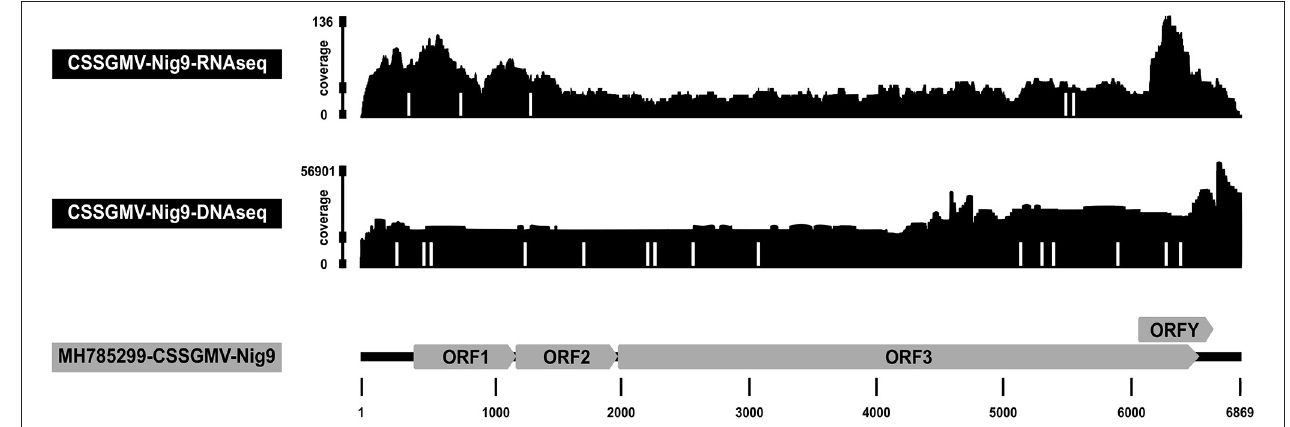
FIGURE 3 | Coverage depth of Illumina reads mapped to the full-length genome of cacao swollen shoot Ghana M virus (CSSGMV)-Nig9. The RNA Illumina sequencing data (top) was obtained from a representative biolistic inoculated cacao plant at 90 days-post-inoculation, while the DNA Illumina reads (middle) were recovered from an agroinoculated plant at 120 days-post-agroinoculation. The positions of single nucleotide variations (SNVs) observed from the RNA and DNA sequencing reads are represented by white bars. The genome organization of CSSGMV-Nig9 is shown at the bottom.